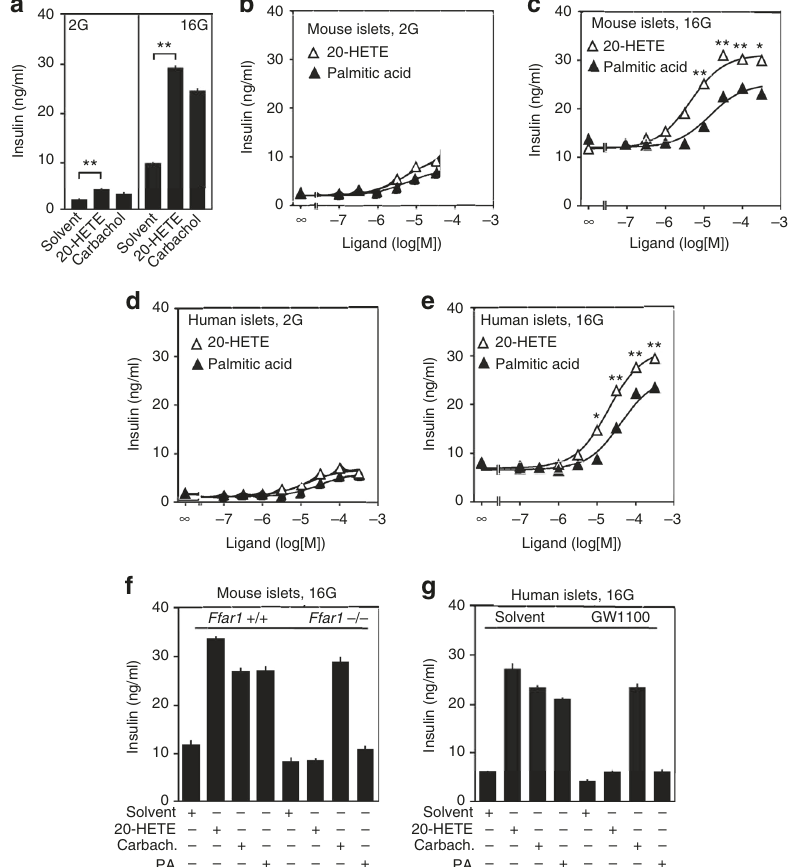
Fig. 2 Stimulation of GSIS by 20-HETE in mouse and human islets is mediated by FFAR1. a Effect of 20-HETE (10 µ M) and carbachol (10 µ M) on insulin secretion from murine islets in the presence of low (2.8 mM; 2G) and high glucose concentrations (16.7 mM; 16G). b – e Effect of 20-HETE and palmitic acid at increasing concentrations on the release of insulin from mouse ( b , c ) and human ( d , e ) islets in the presence of 2.8 mM (2G) ( b , d ) or 16.7 mM (16G) glucose ( c , e ). f , g Effect of 30 μ M of 20-HETE, carbachol (carbach.), and palmitic acid (PA) on the release of insulin from murine ( f ) and human ( g ) islets. Murine islets were prepared from wild-type ( Ffar1 +/+ ) or Ffar1-de fi cient mice ( Ffar1 − / − ), and human islets were co-incubated with 30 μ M of FFAR1 antagonist GW1100 or solvent. Shown are mean values ± s.e.m., n = 9; * P ≤ 0.05; ** P ≤ 0.01 (Student ’ s two-tailed t